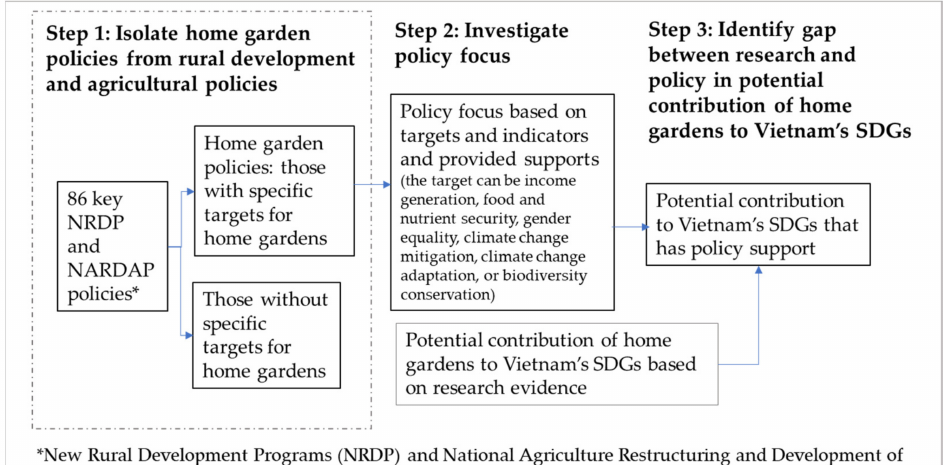
Figure 1. Three-step policy review in this